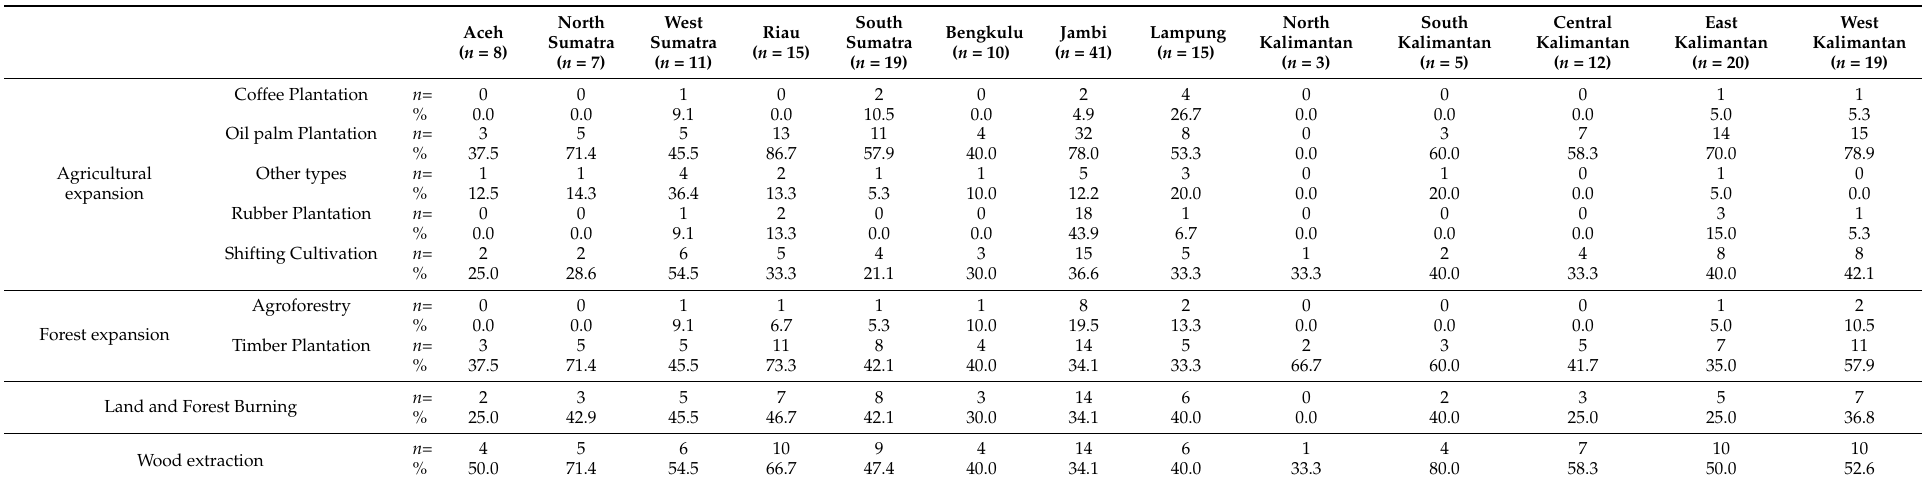
Table A5. Frequency of direct causes of land change in Sumatra and